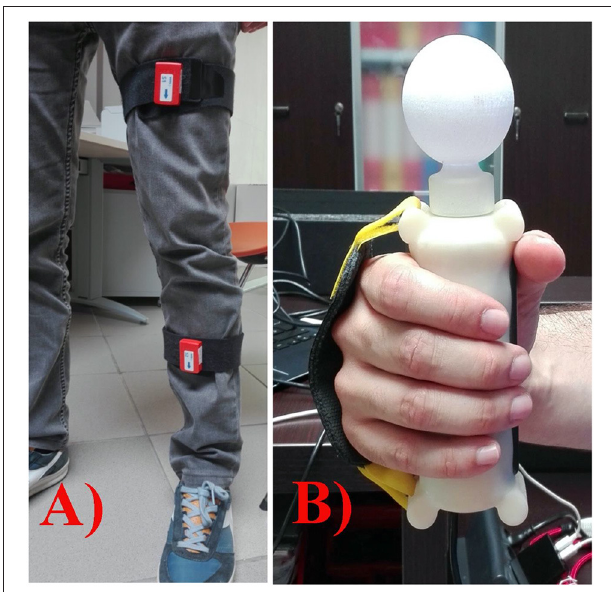
FIGURE 1 | Khymu (A) and KWand (B) devices for telerehabilitation. to the trunk and the upper/lower limbs, or reaching the target holding the K-wand, it is possible to train the different body segments.